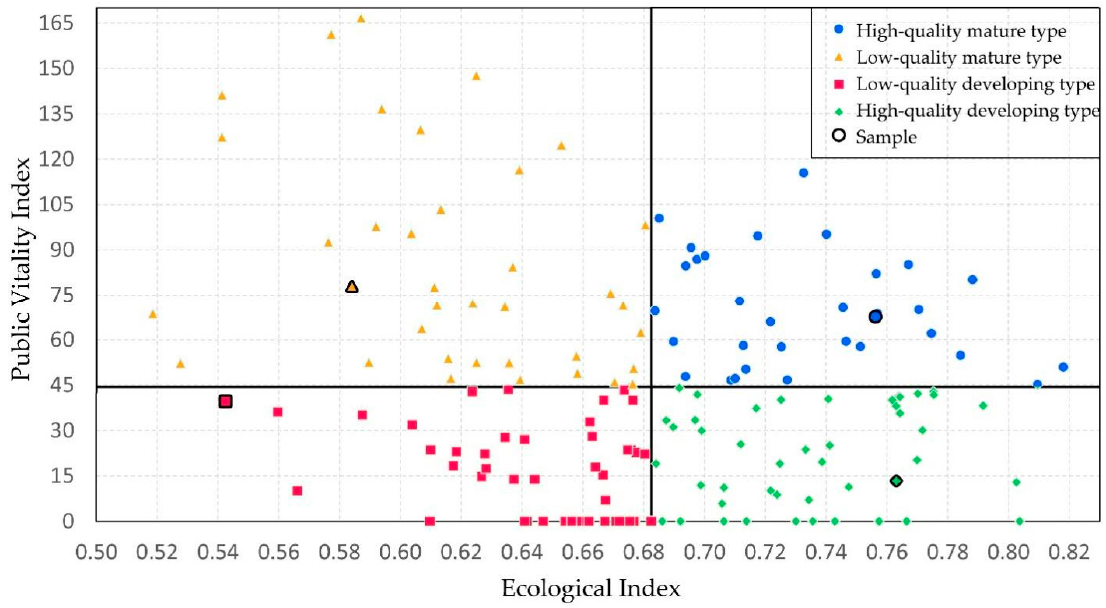
Figure 18. Four-quadrant classification of UGI landscape activity.